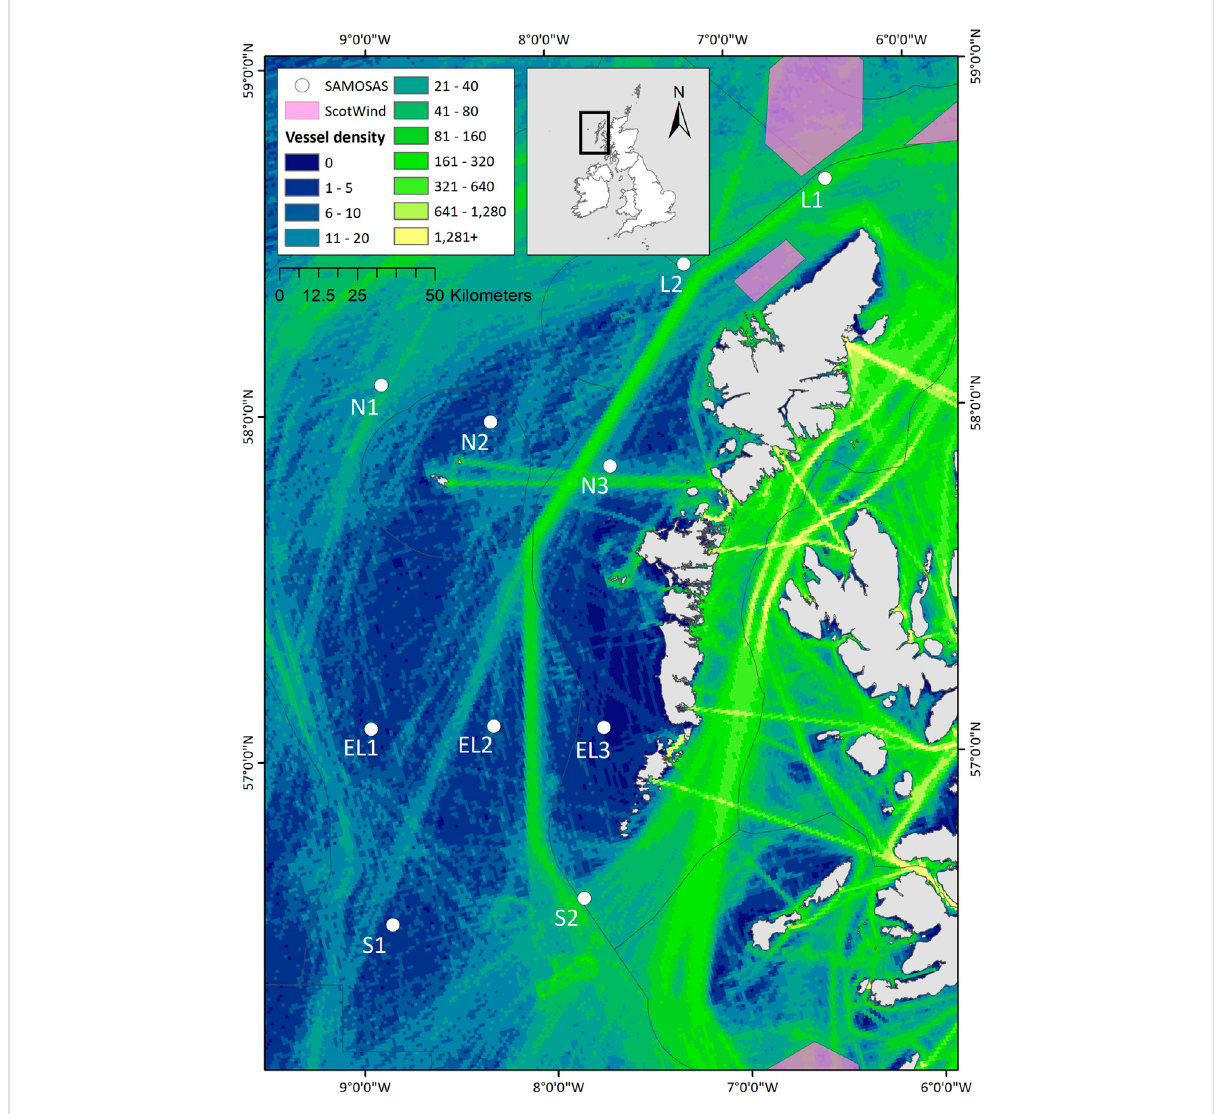
FIGURE 1 Mapofthestudy areaoff western Scotland, showing thepassiveacousticmonitoring locations (i.e. theSAMOSAS array)analysedinthisproject. The black box in the inset map shows thestudy area in relation to Britain and Ireland. The Outer Hebrides refers to thechain of islands oriented from NNEtoSSWwestoftheScottishmainlandaspresentedinthemainplot;Shetlandisthenorthernmostislandgroupingvisibleintheinset.Background colours represent the 2019 Automated Identi fi cation System (AIS) ship traf fi c data. Vessel densities are represented as the annual number of routes per km 2 . AIS data source: EMODnet Human Activities - European Maritime Safety Agency (EMSA) Route Density Map. The ScotWind 1 leasing areas 2 are indicated as pink